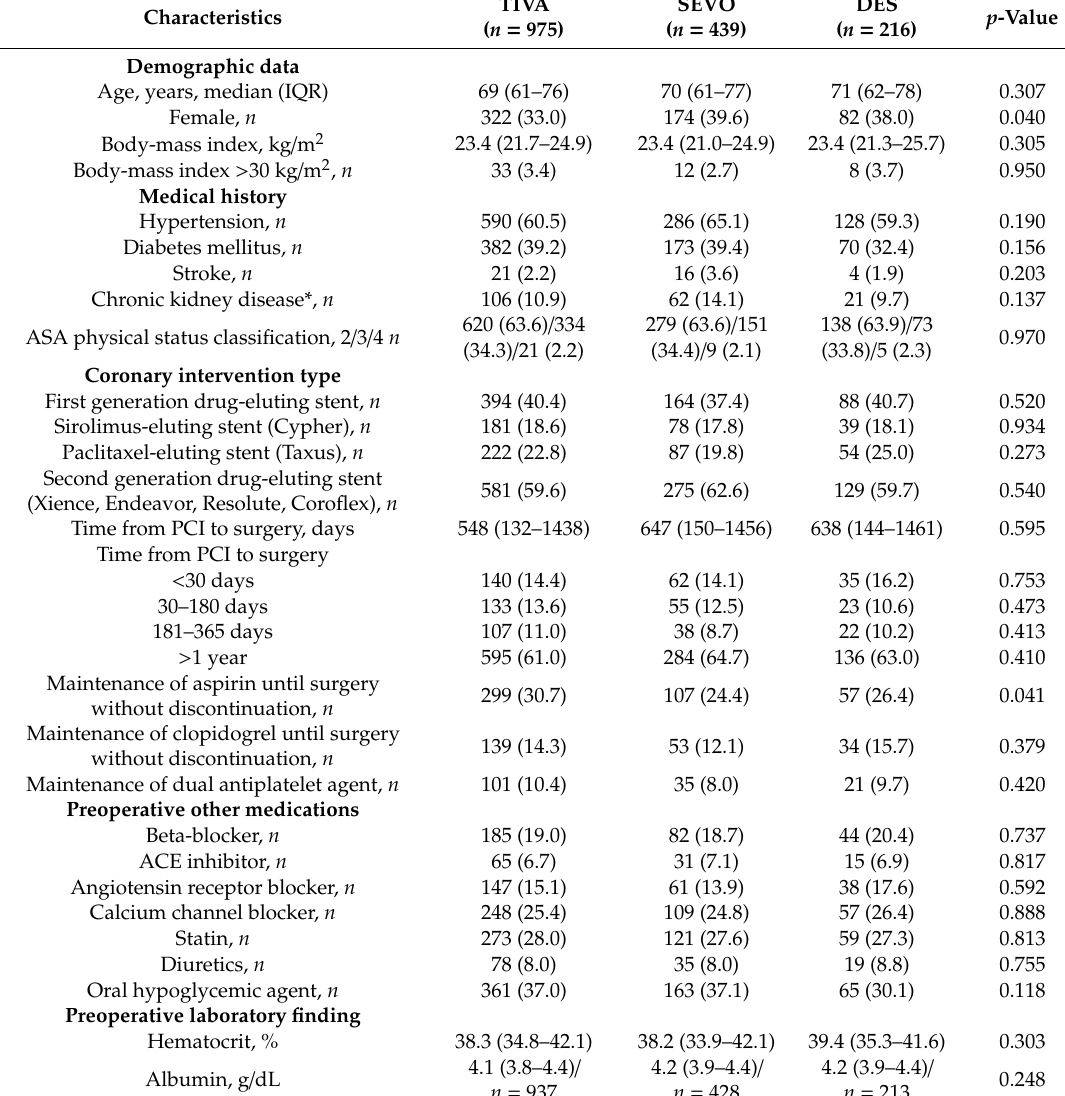
Table 1. Baseline characteristics of patients between anesthetics used during the